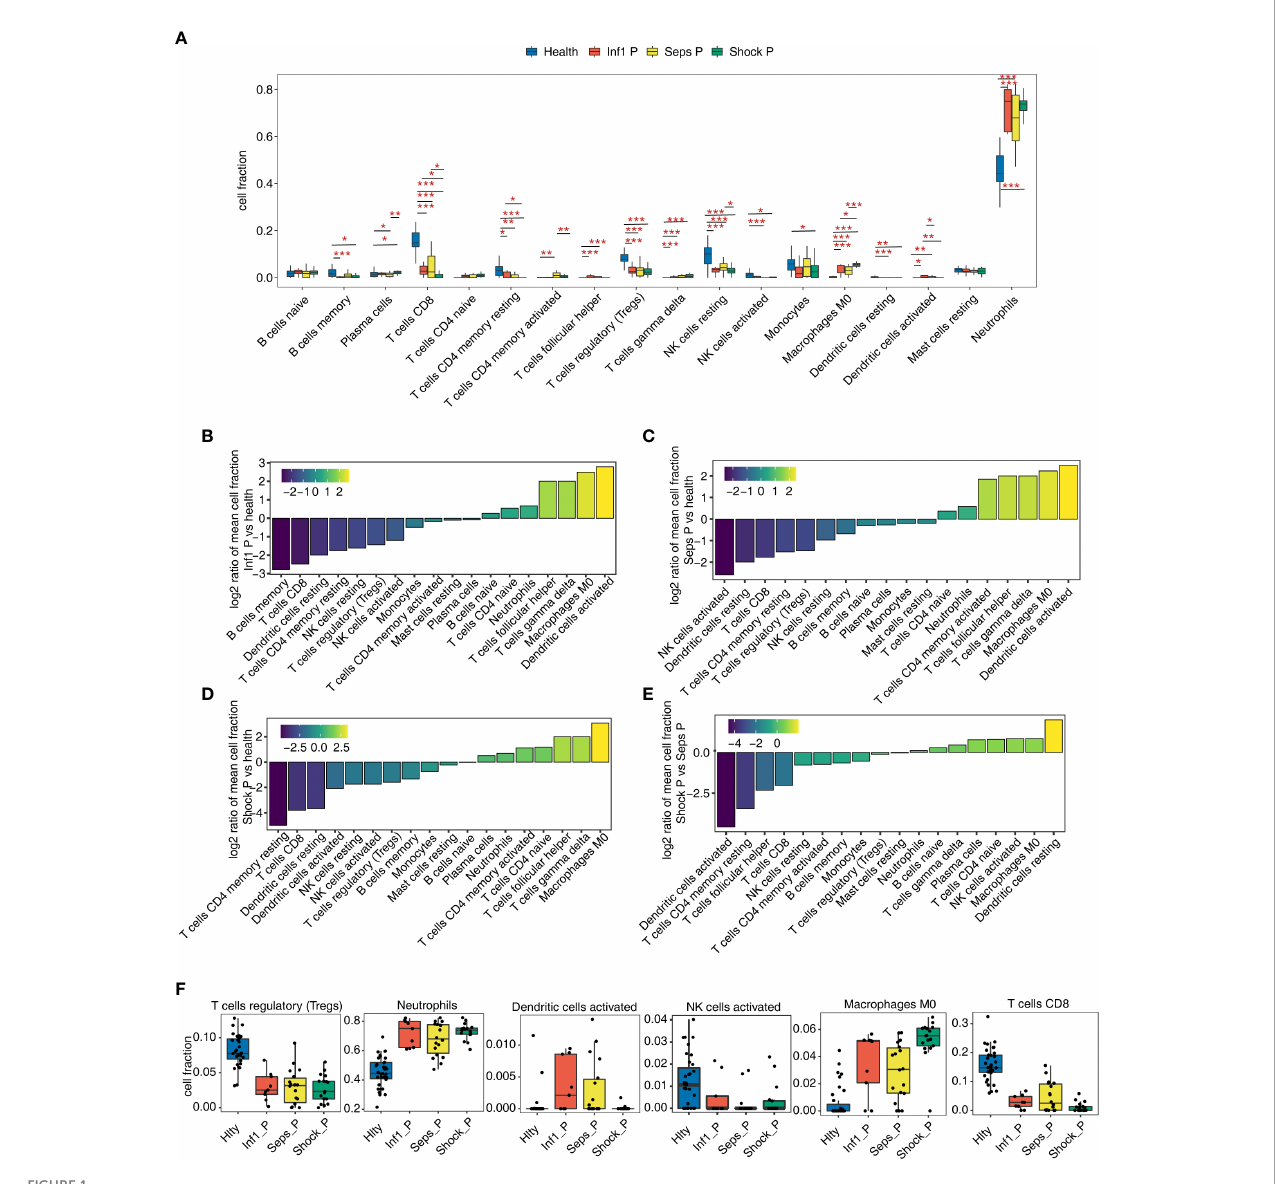
FIGURE 1 Diversity of immune microenvironment characteristics in whole blood among healthy donors and sepsis patients. (A) Boxplot showing fraction of each cell type in each group. The signi fi cant difference of cell fractions among healthy donors and sepsis patients was calculated using the Student ’ s t-test. *P ≤ 0.05, **P ≤ 0.01, ***P ≤ 0.001. (B) Inf1 P group relative to Hlty group rank ordered based on decreasing values of the relative frequency ratio at Inf1 P vs. Hlty. (C) Seps P group relative to Hlty group rank ordered based on decreasing values of the relative frequency ratio at Seps P vs. Hlty. (D) Shock P group relative to Hlty group rank ordered based on decreasing values of the relative frequency ratio at Shock P vs. Hlty. (E) Shock P group relative to Hlty group rank ordered based on decreasing values of the relative frequency ratio at Shock P vs. Seps P. (F) Boxplot showing cell fraction of fi ve cell